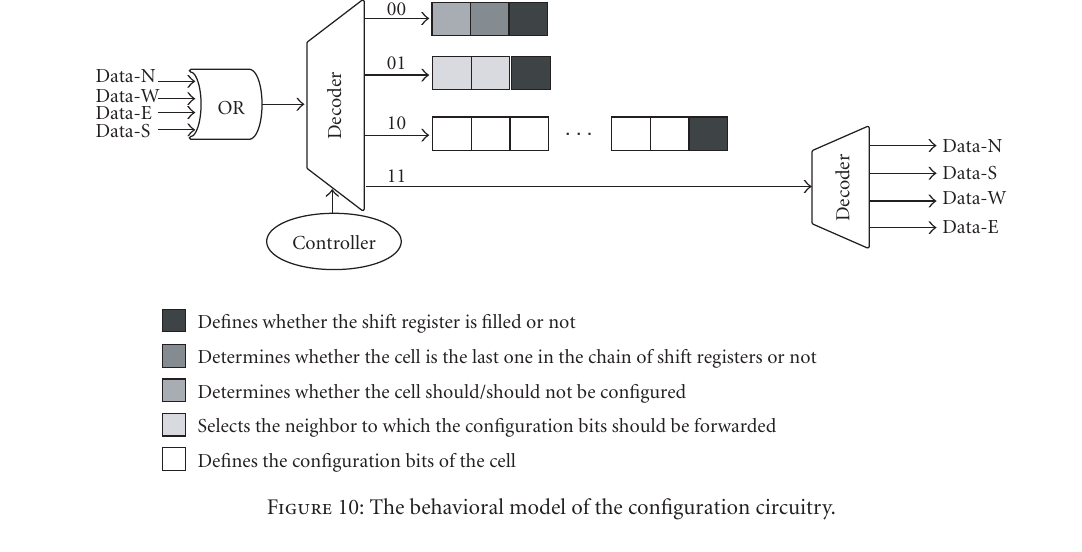
Figure 10: The behavioral model of the configuration circuitry.